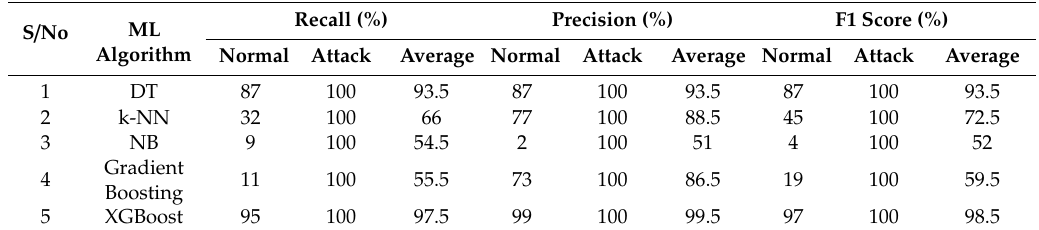
Figure 14. Average performance of classifiers in multiclass classification. Table 7. Binary classification precision, recall, and F1 Score.